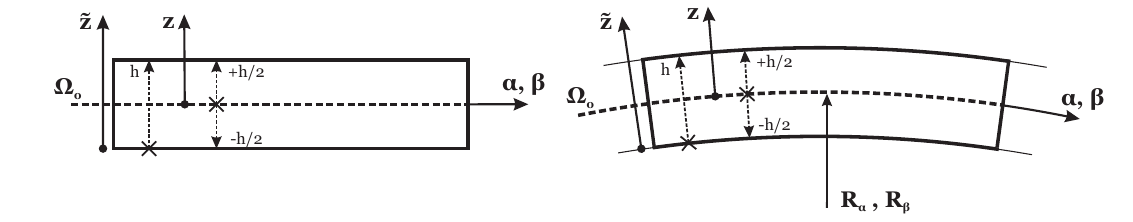
Figure 2. Thickness coordinates z and ˜ z , and reference systems for shell